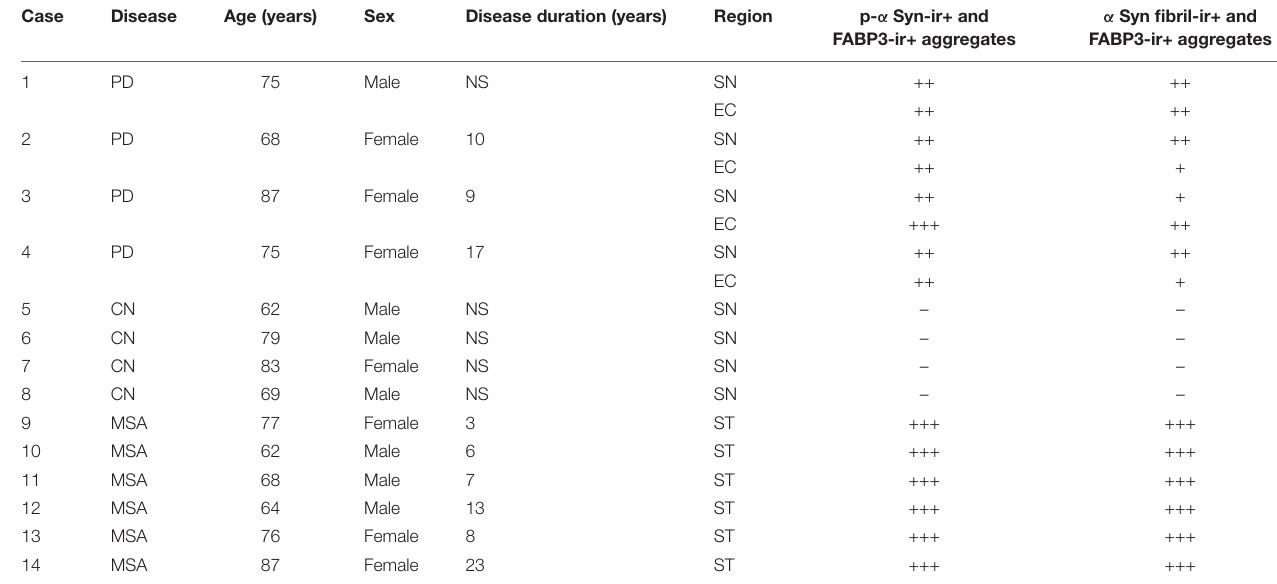
TABLE 1 | Demographic profiles of autopsy cases and the results of immunostaining for colocalization of p- α Syn and α Syn fibril aggregates with FABP3 accumulations.